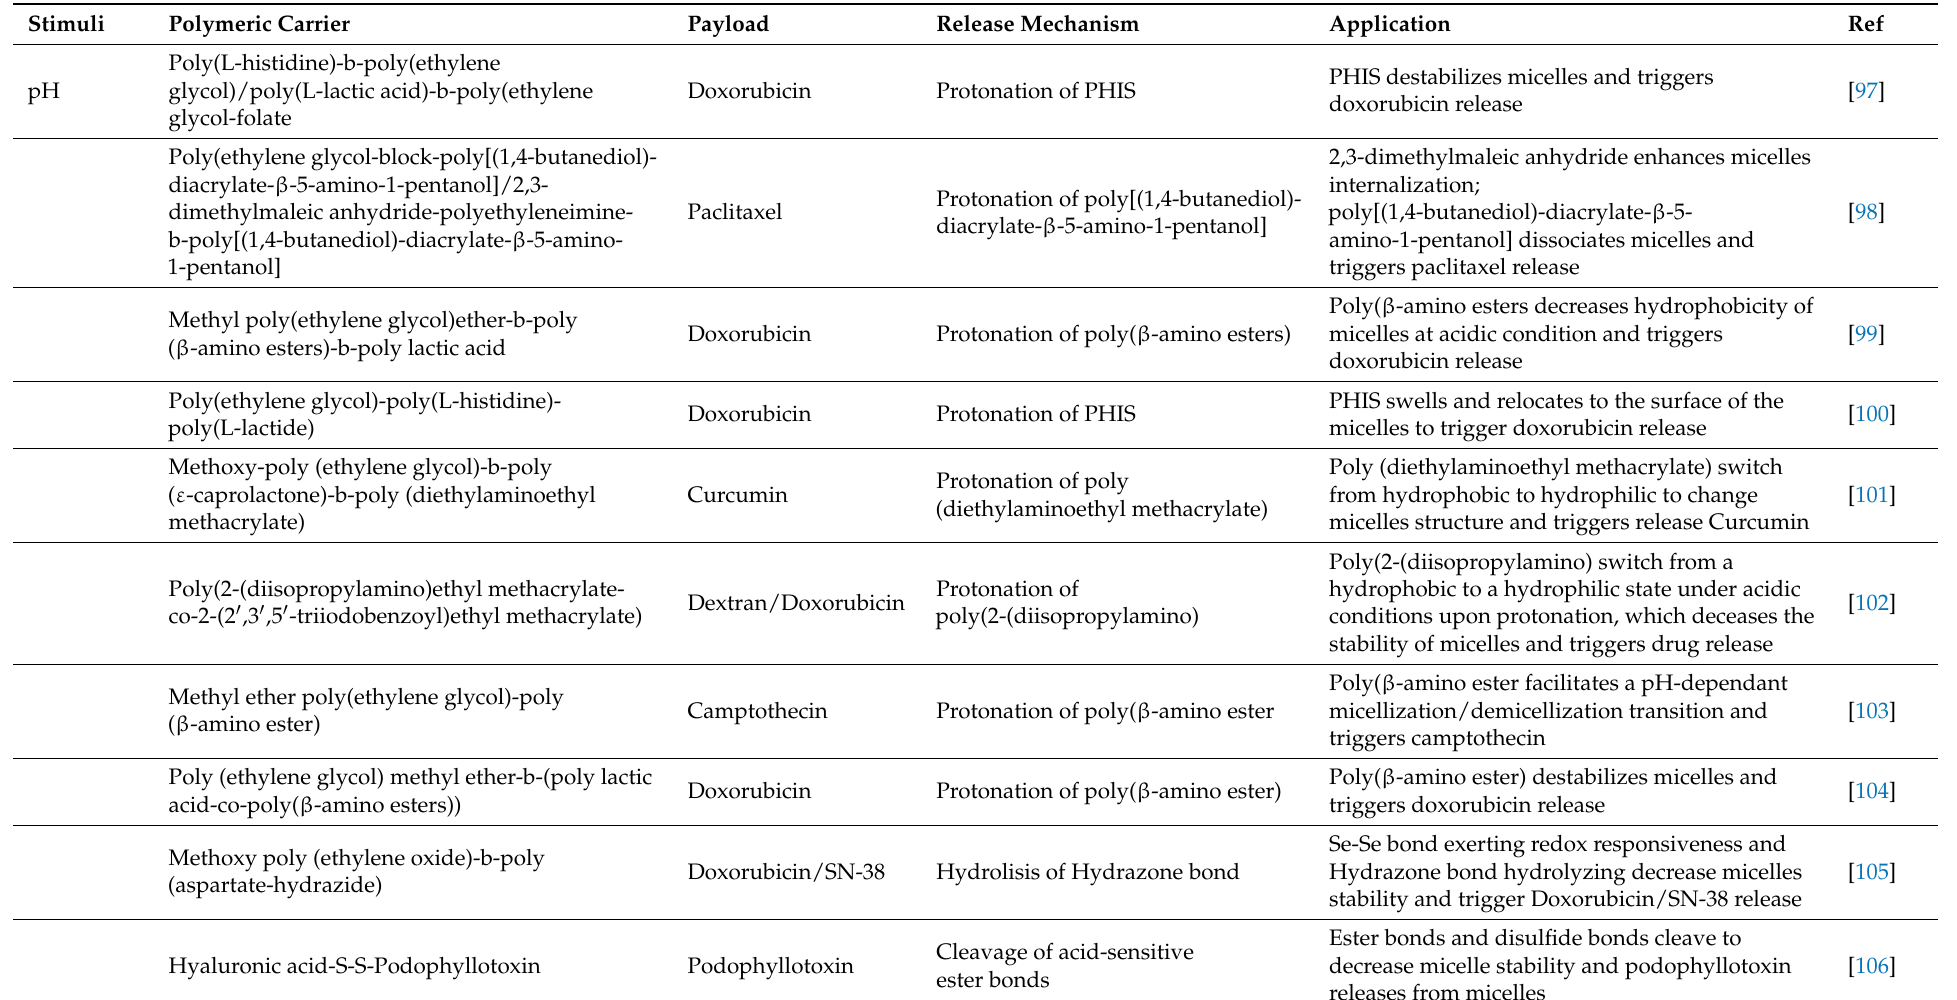
Table 3. Stimuli polymeric micelles for drug